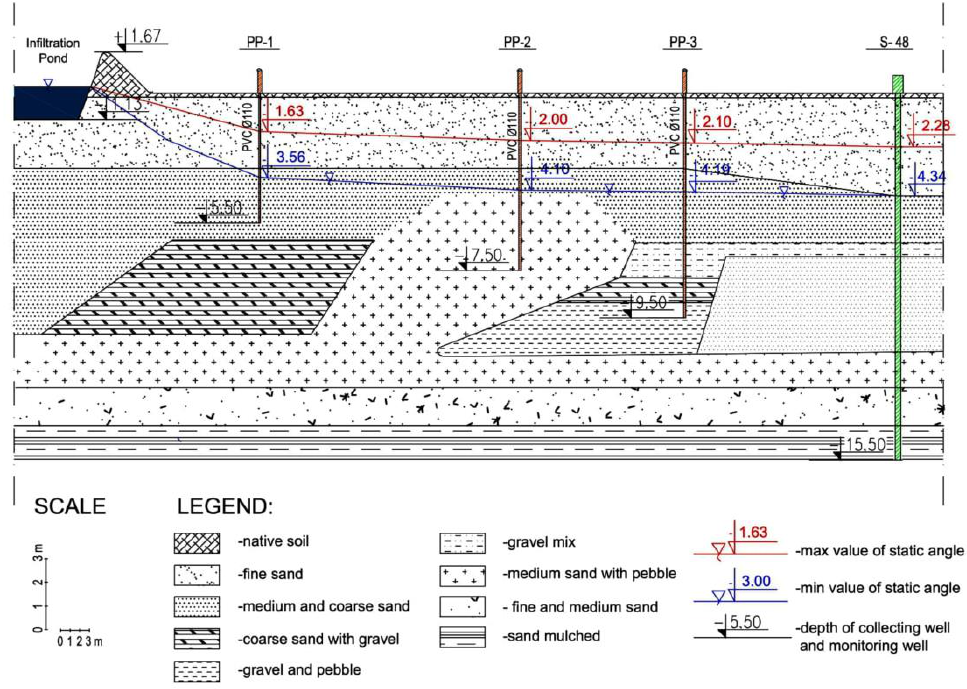
Figure 1. The cross section of the infiltration path [22].